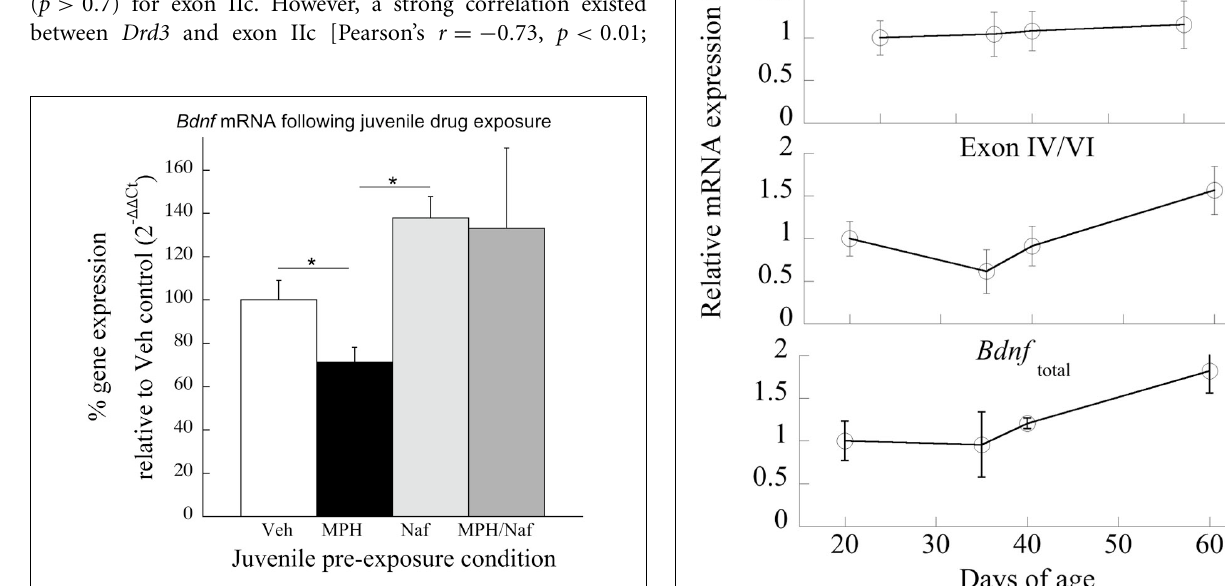
FIGURE 5 | Changes in mRNA expression of Bdnf and its exon-specific splice variants I, IIc, III/IV, and IV/VI as a function of age. Data are expressed following correction for GAPDH levels run simultaneously. n = 5–6/age, with Means ± SE